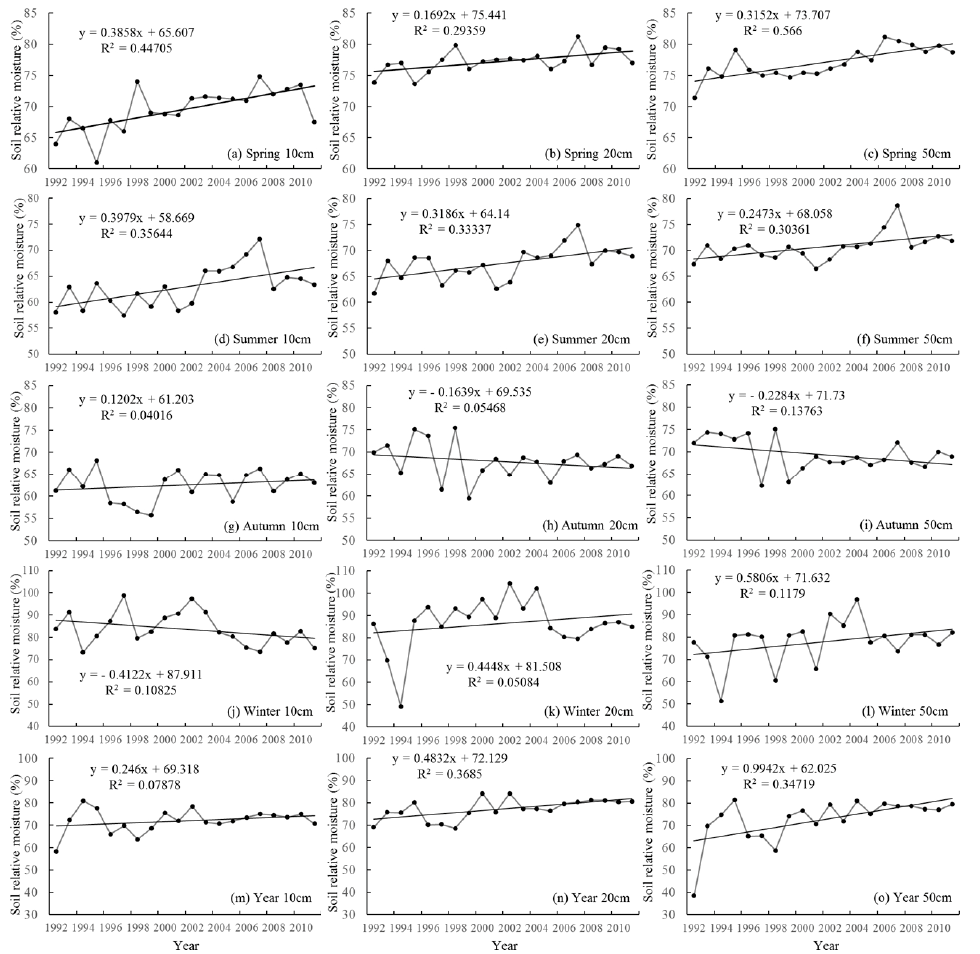
Figure 4. The variation of the relative soil moisture of farmland in arid inland river basin areas during